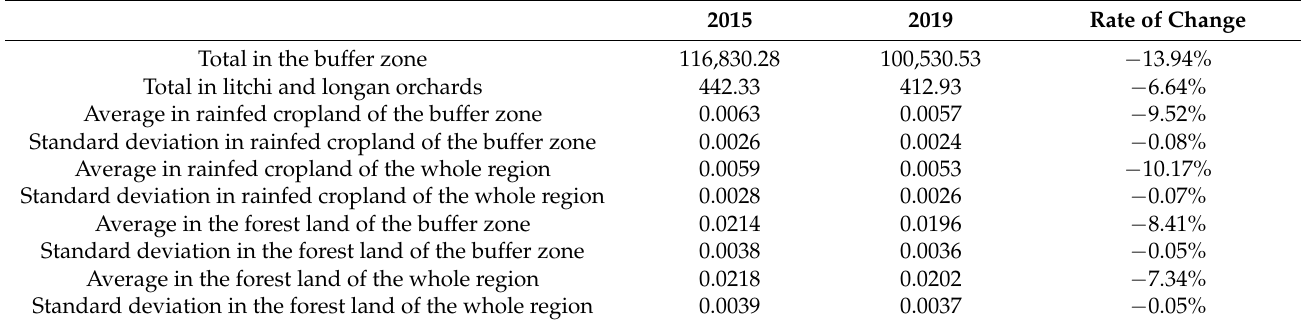
Table 3. Abundance of wild bee in litchi and longan orchards and their buffer zones in Huizhou,